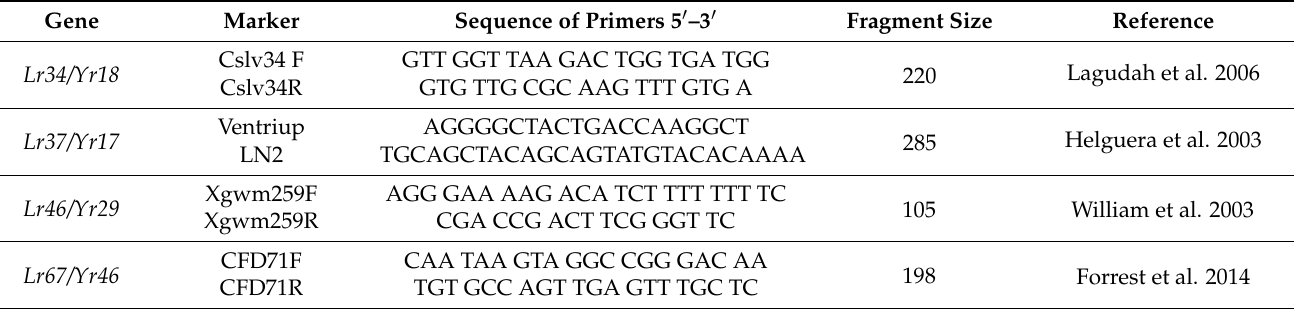
Table 2. Names, sequences, and references of specific primers linked to the tested genes used in this study. Gene Marker Sequence of Primers 5 (cid:48) –3 (cid:48) Fragment Size